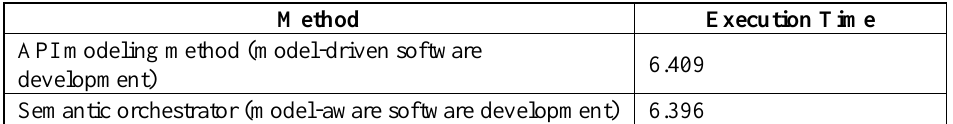
Table 2. Comparison between averages in the model-driven approach and the model-aware